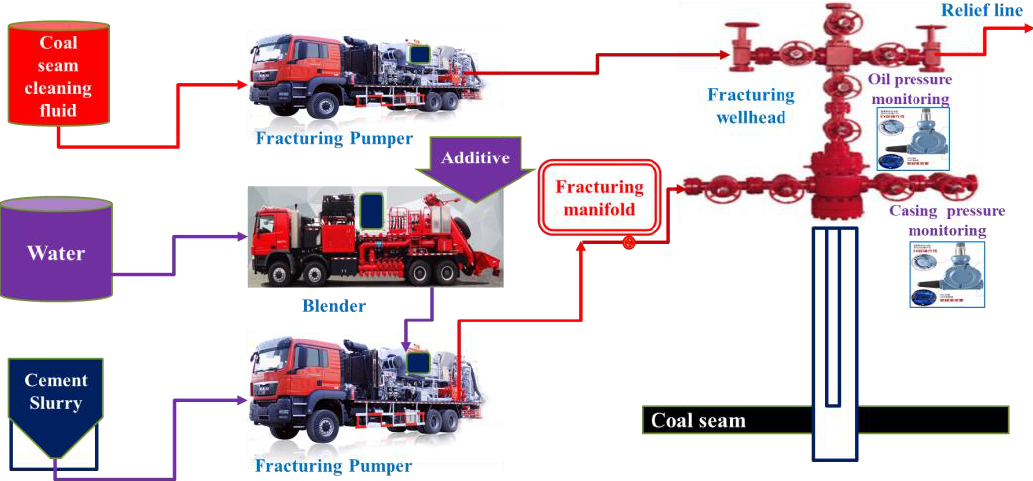
Figure 19. On-site fracturing operation flow chart.